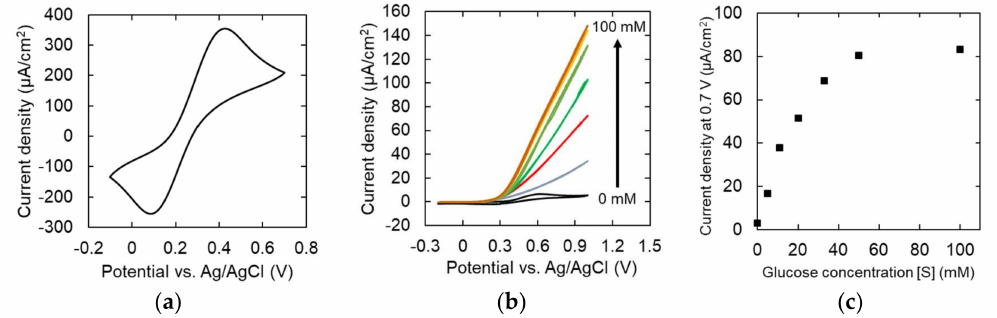
Figure 5. Cyclic voltammogramss recorded at the chemical vapor deposition (CVD)-grown graphene on SiO 2 / Si substrate for 10 mM 1,1-ferrocenedicarboxylic acid in ( a ) the absence and ( b ) presence of glucose and 5–100 mM glucose and 10 µ M GOx in 0.2 M phosphate bu ff er solution at scan rate of 50 mV / s and ( c ) plots of its catalytic current at E = 0.7 V vs. glucose